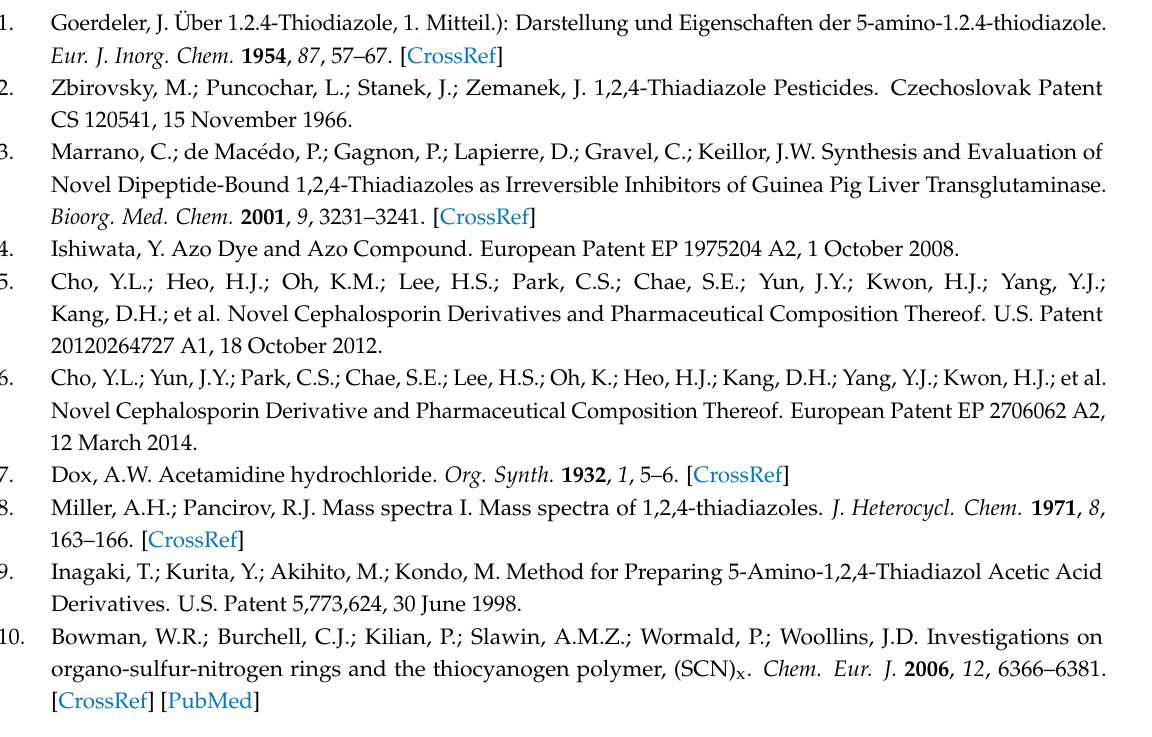
Supplementary Materials: The following are available online, Figure S1: 400 MHz 1 H-NMR spectrum of 1 in CD 3 OD, Figure S2: 100 MHz DEPTQ 13 C-NMR spectrum of 1 in CD 3 OD, Figure S3: 400 MHz 1 H-NMR spectrum of 1 in CD 3 SOCD 3 , Figure S4: 100 MHz DEPTQ 13 C-NMR spectrum of 1 in CD 3 SOCD 3 , Figure S5: IR (ATR) spectrum of 1